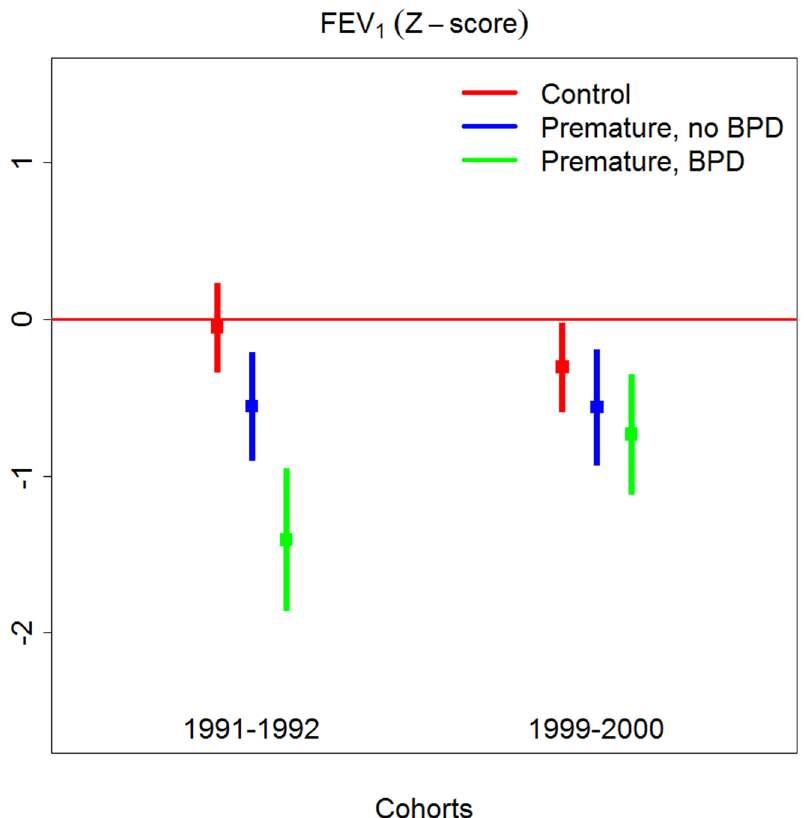
Fig 2. Z-FEV 1 in 11 year old term and preterm-born (EP) subjects born in 1991 – 92 and 1999 – 2000, EP- born split by the presence of BPD.